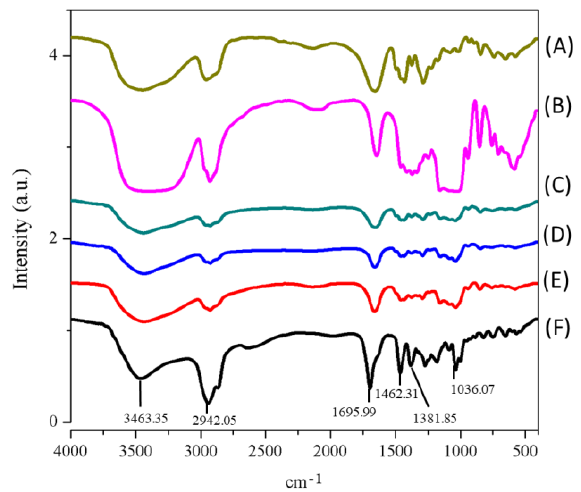
Figure 5. Fourier transform infrared (FTIR) spectra of OA and OAnf with different ratios and excipients. ( A ) PVPK90, ( B ) HPBCD, the different ratios of OAnf (OA: PVP: HPBCD, w / w / w ) ( C ) 1:8:5, ( D ) 1:8:10, ( E ) 1:8:20, and ( F ) oleanolic